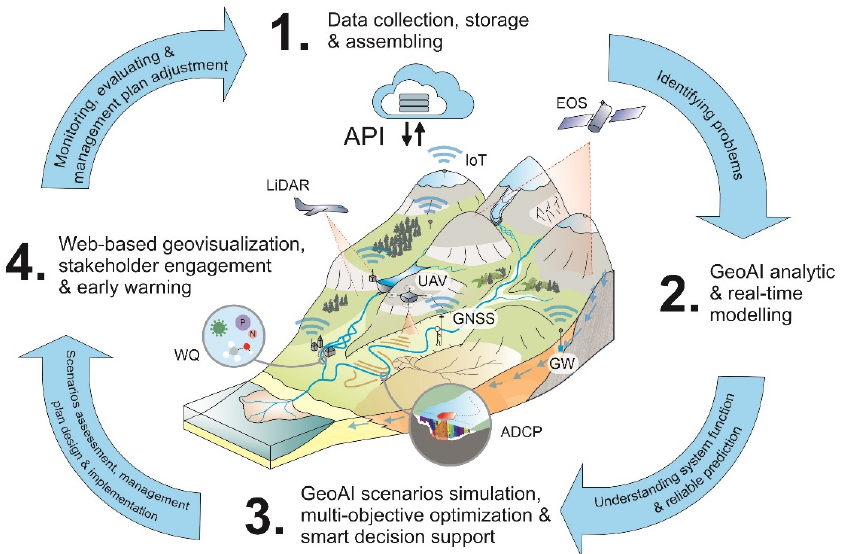
Figure 2. A GeoAI application model for a smart decision support system for integrated water re- sources management (IWRM). (1) Internet of things (IoT) supports real-time, high-frequency,